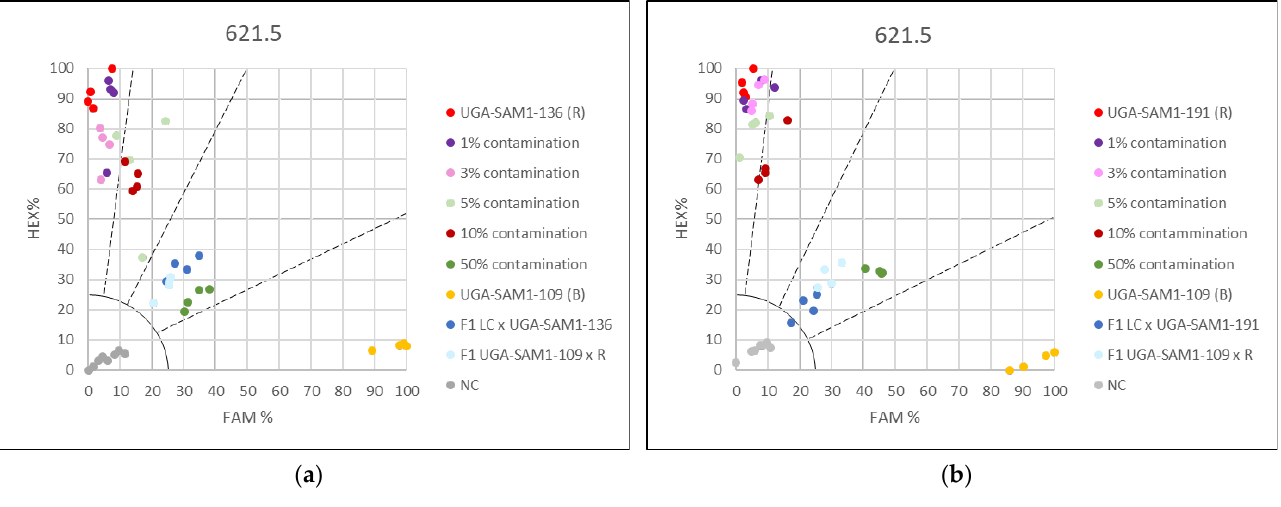
Figure 4. Genetic purity testing for hybrid breeding using hypocotyls and KASP marker 621.5. ( a )